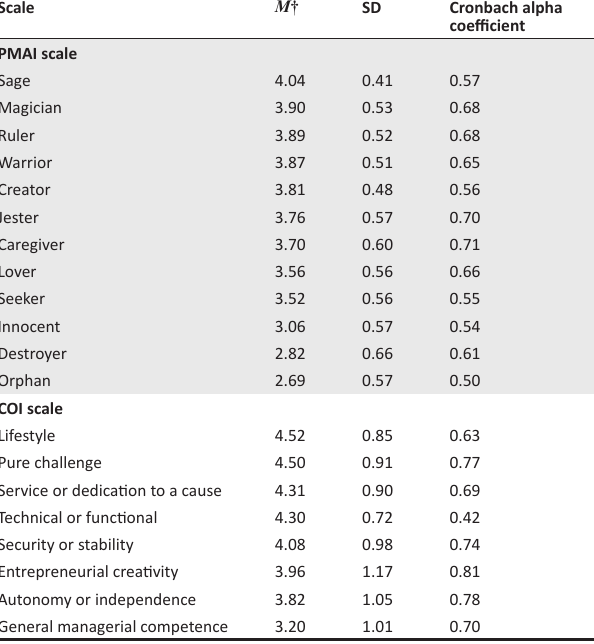
TABLE 3: Descriptive statistics: PMAI and COI ( N =